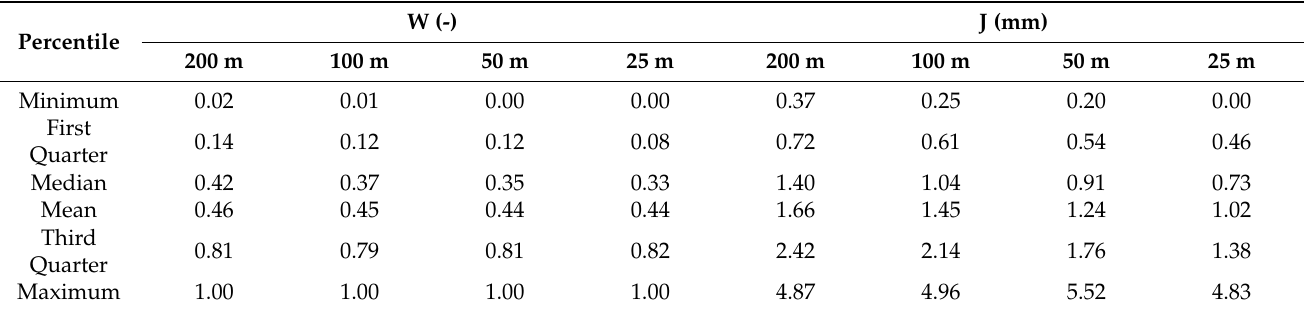
Table 5. Five-number summary for the calculated values of W and J indices.